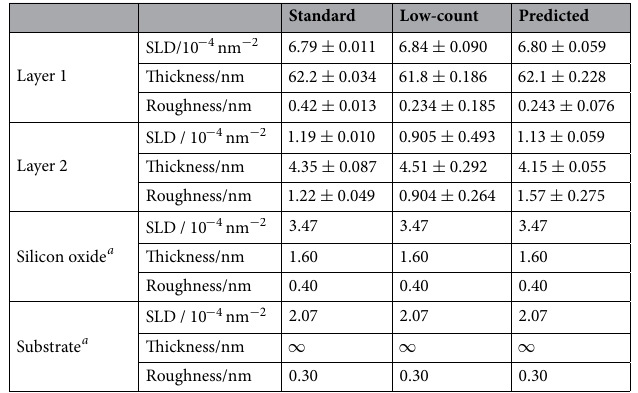
NR profile and the SLD distribution obtained for the standard data (green curve), low-count data (blue), and predicted data (red). Although the obtained SLD profile by the low-count NR data was different from that obtained for the standard data at the depth of 60–70 nm as shown in Fig. 4b, the result of the fitting analysis of the predicted data was in good agreement with the standard data. The obtained best fitted parameters with the standard deviation are summarized in Table 2. The values of the thickness and the SLD of the layer 1, which cor- responds to the d-PMMA layer, are almost the same for all of the data. These structural parameters are mainly characterized by the critical q of the total reflection and frequency of the Kiessig fringe pattern 2 , which are clearly observed also in the NR profile with 5% neutron counts (the blue circles in Fig. 4a). Therefore, the thickness and SLD of the d-PMMA layer can be determined from the NR data with an accuracy less than a few percents. On